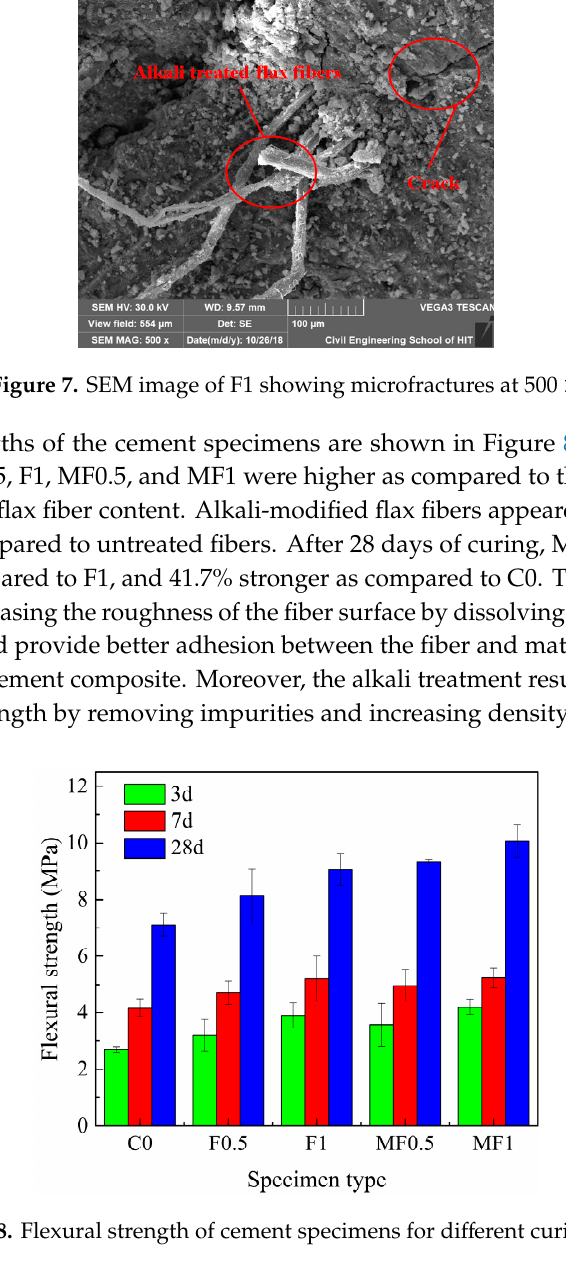
Figure 6. Compressive strength of cement specimens for different curing ages.